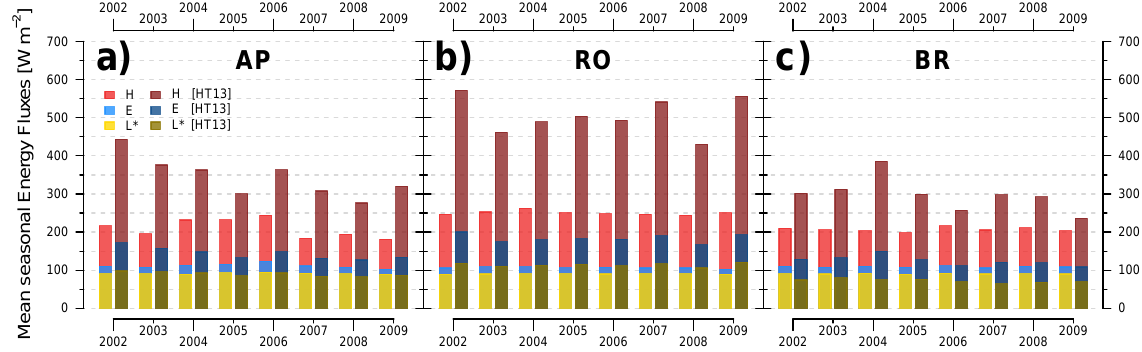
Figure 13. Average wintertime (May to September) energy fluxes of sensible/latent heat ( H/E ) and net long-wave radiation ( L ∗ ) for the years 2002 to 2009 in Wm − 2 . The corresponding model results from Haid and Timmermann (2013) are shown in darker color tones.